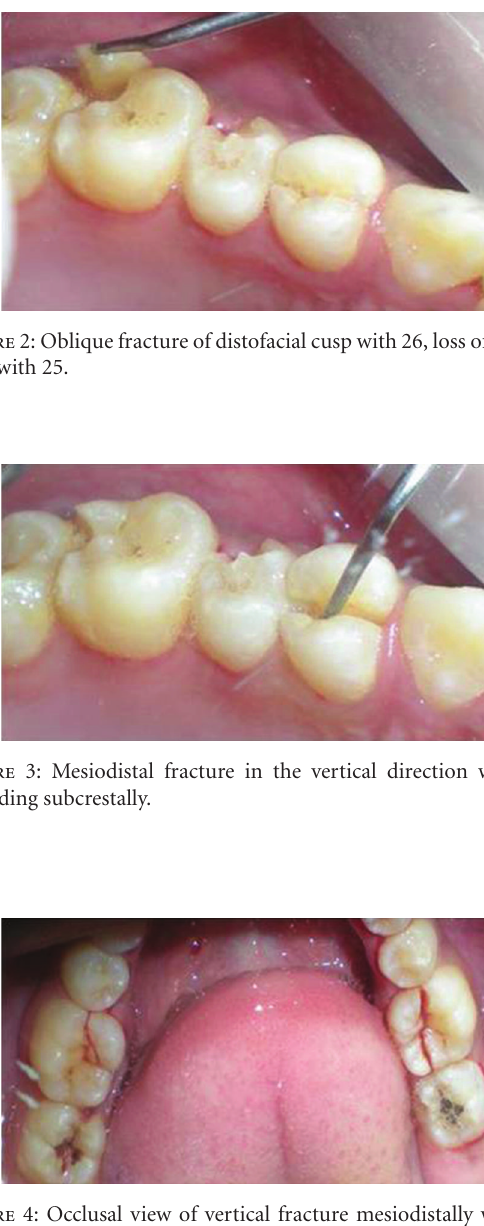
Figure 5: Preoperative radiograph revealing oblique fracture involving distal aspect of the tooth 16.